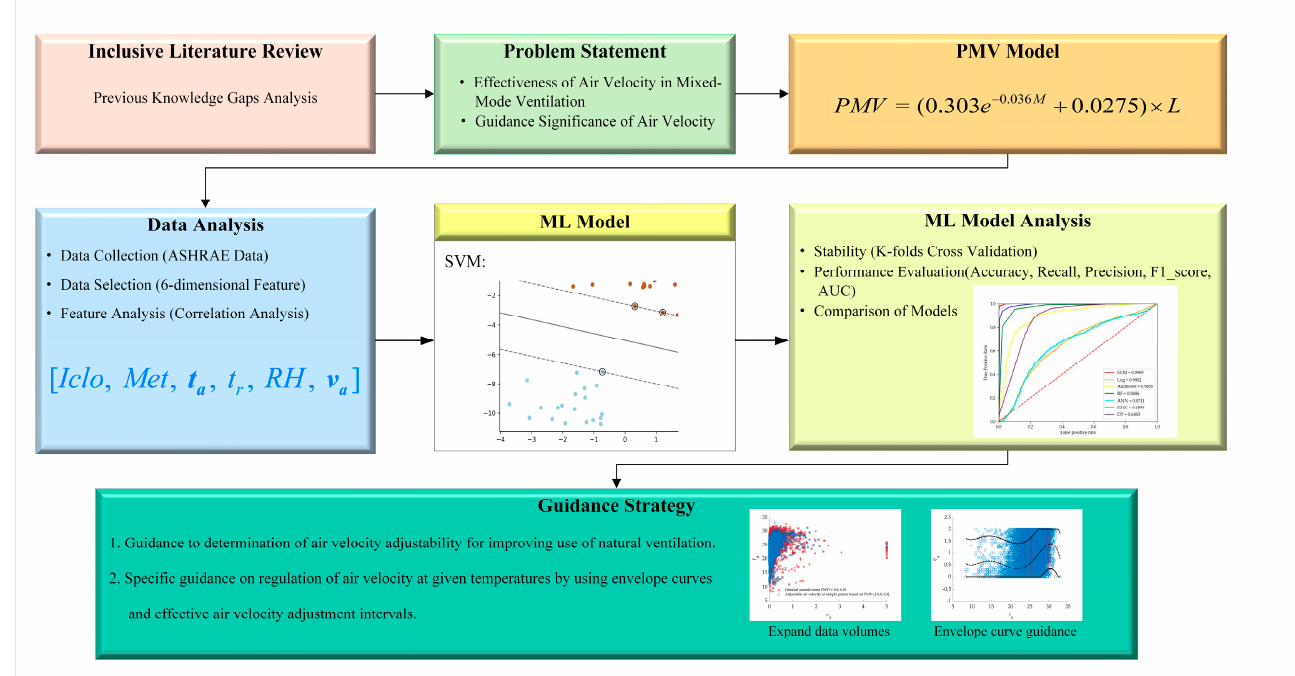
Figure 1. Main framework in the role and method of continuous air velocity adjustment in mixed- mode ventilation. mode